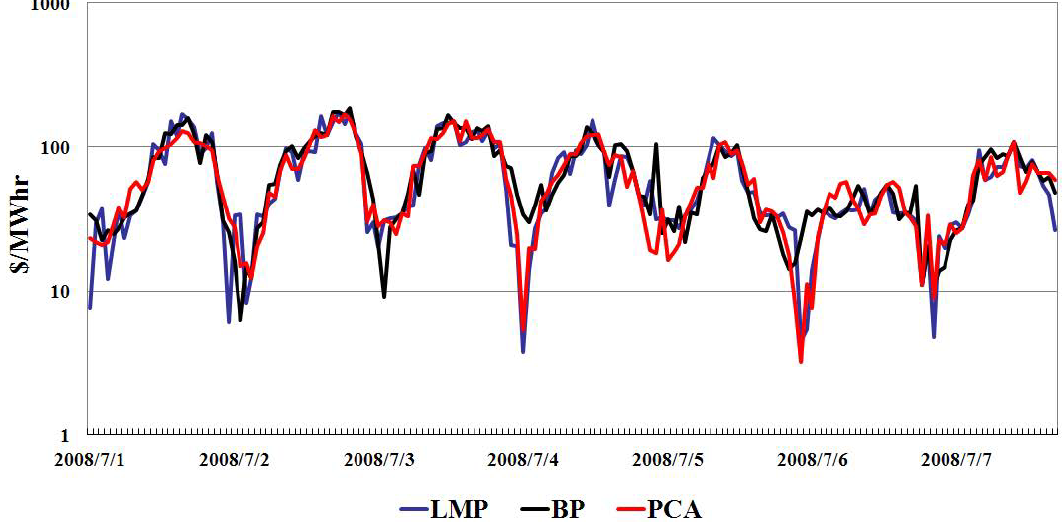
Figure 6. Comparisons among actual, BP-based and hybrid PCA-based LMPs for Fisk.